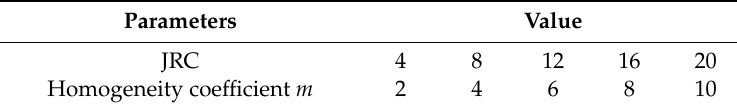
Table 2. List of simulation schemes.